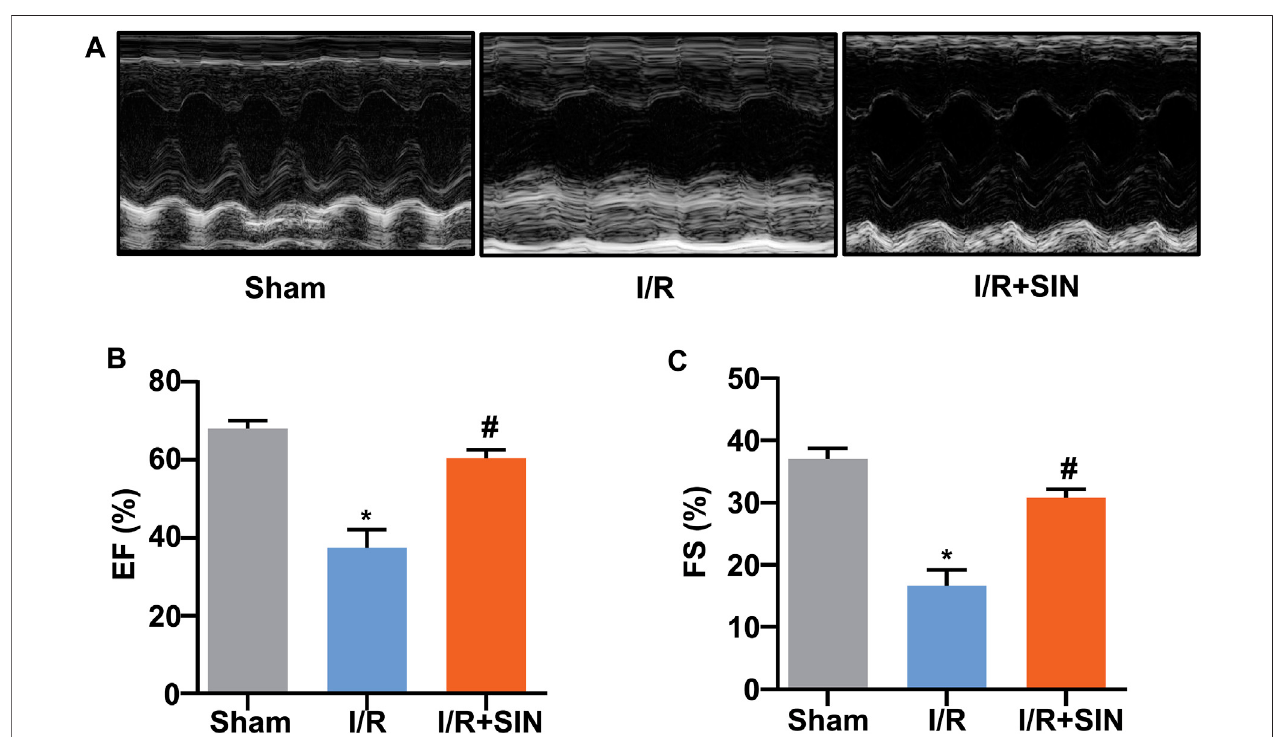
FIGURE 2 | Effect of SIN on cardiac structure and function in MIRI mice. (A) Representative images show the changes in cardiac structure detected by echocardiography in mice treated with or without MIRI and/or SIN. (B,C) Quantitative analysis show that pretreatment with SIN prevented the MIRI-induced decrease in ejection fraction EF, (B) and fractional shortening FS, (C) values ( n = 5, * p < 0.05 vs. sham, # p < 0.05 vs. I/R). Data are shown as means ± SEM.